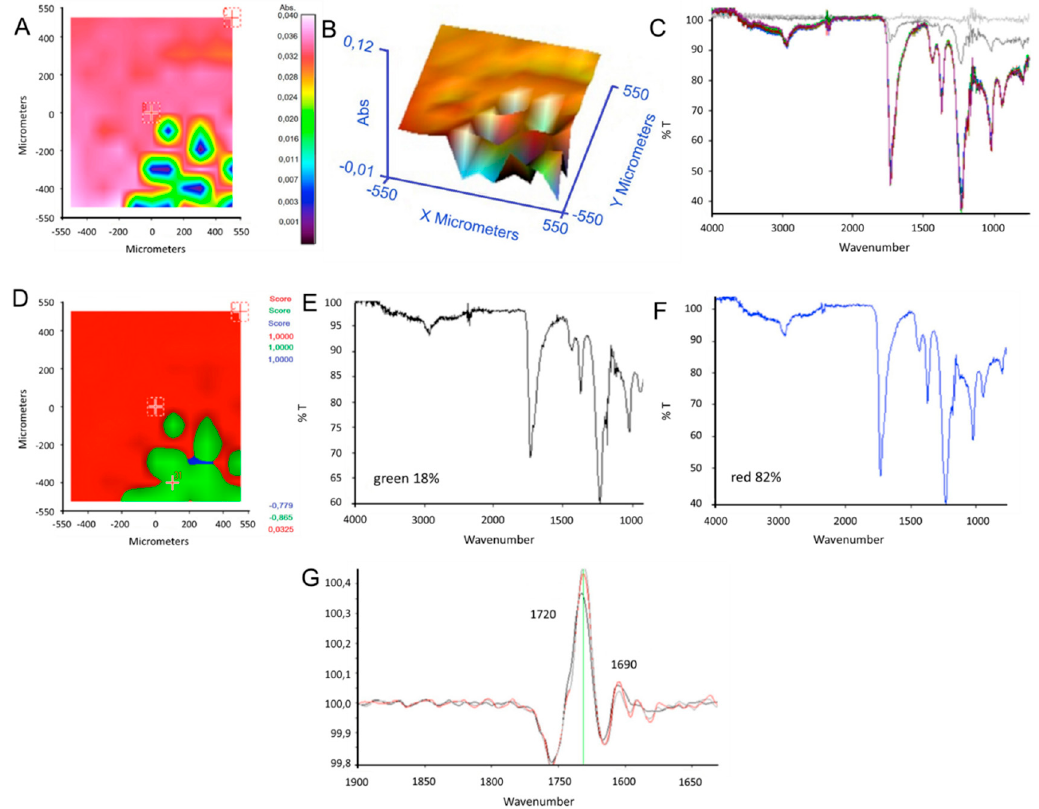
Figure 2. Chemical map in 2D ( A ), in 3D ( B ), and corresponding ( C ) spectra of P(VAc- co -AA) primer after deposition on Ti substrate; PCA analysis map ( D ) and spectra corresponding to green area ( E ) and red area ( F ); derivative spectra acquired in green area ( G ).